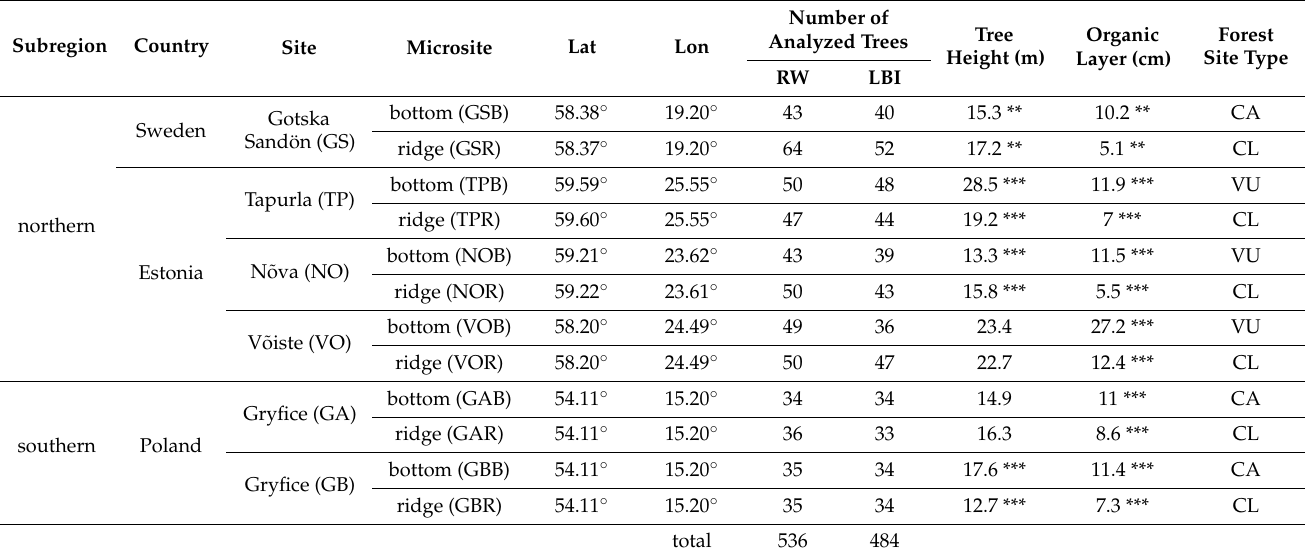
Tree height and organic layer were tested for significant difference between mean of each pair of the ridge and bottom microsites using a Wilcoxon rank-sum test. ** significantly different; ( p < 0.01). *** significantly different ( p <